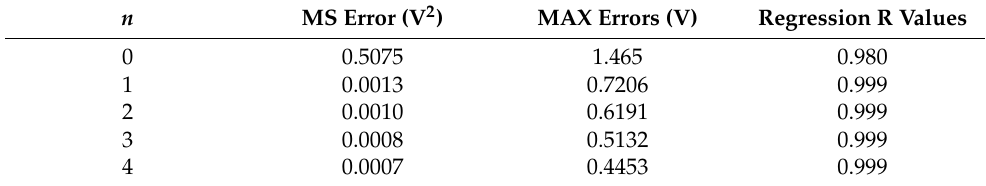
Table 2. The modeling accuracy of the proposed MFNN model using different n values.